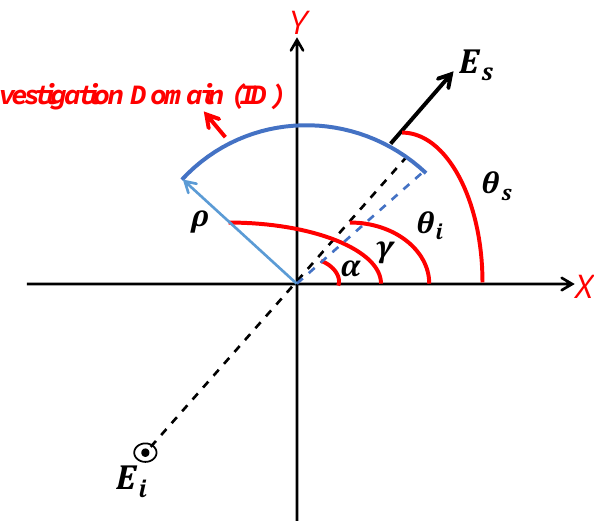
Figure 5. The geometry of the general circumference problem.